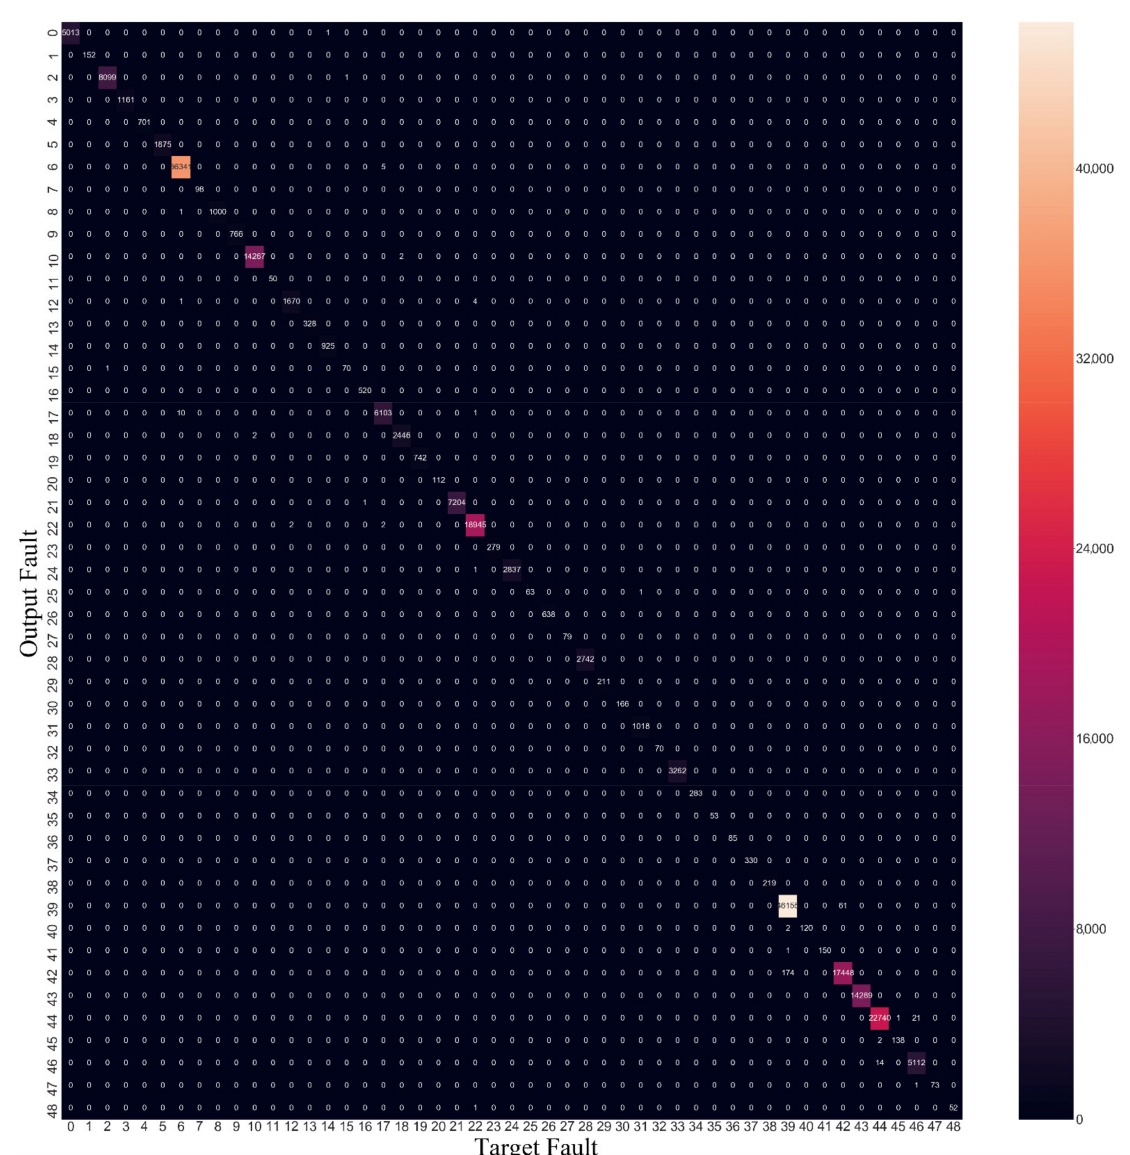
Figure 7. Training time of every classifier on the actual data.